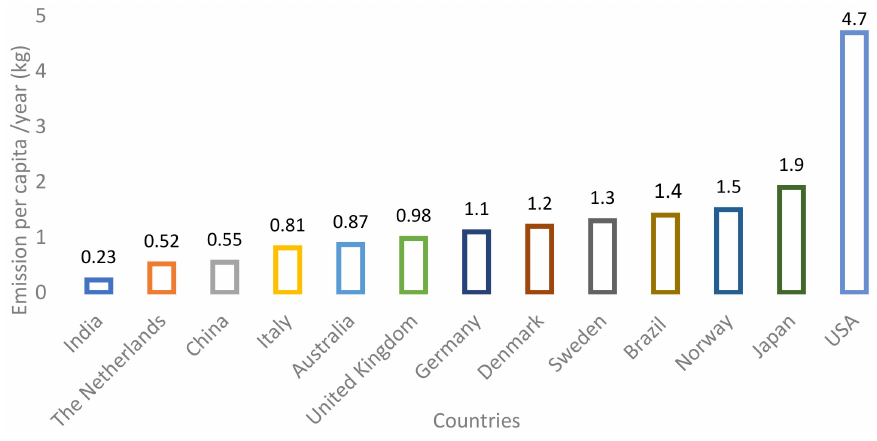
Figure 1. The amount of wear and tear of car tyres emitted per capita per year